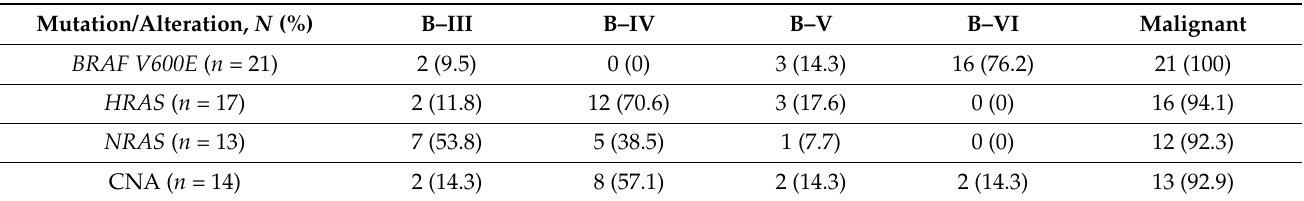
Table 5. Bethesda Score Proportions and Malignancy Rates of Gene Expression Alteration-Associated Mutations and